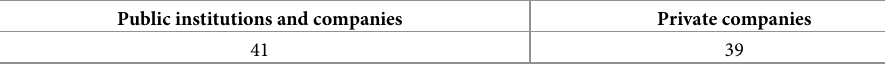
Table 4. The type of the enterprise the employees work for (N = 80).